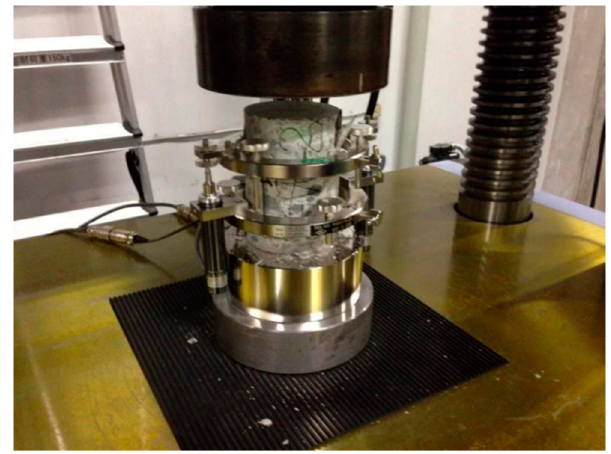
Figure 1. The compressive strength experiment of concrete core.